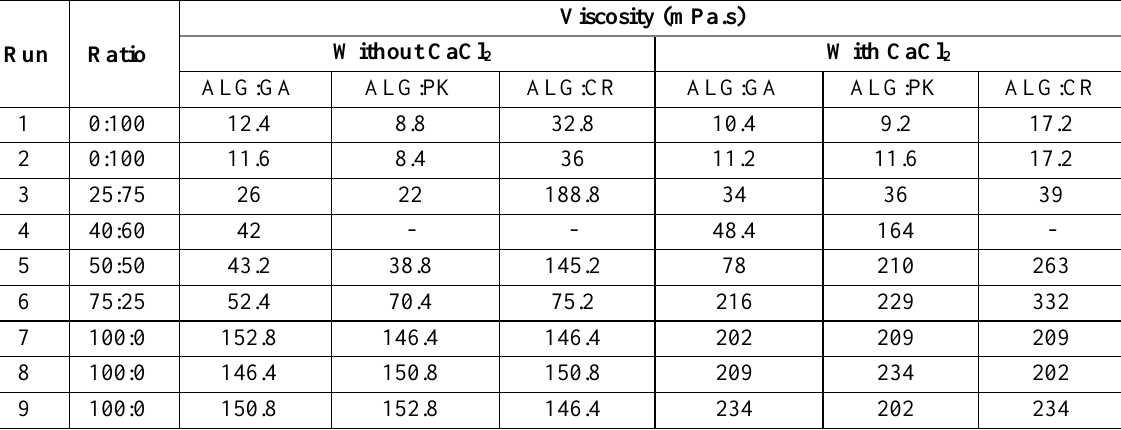
Table 1. Design of experimental for combination polymers